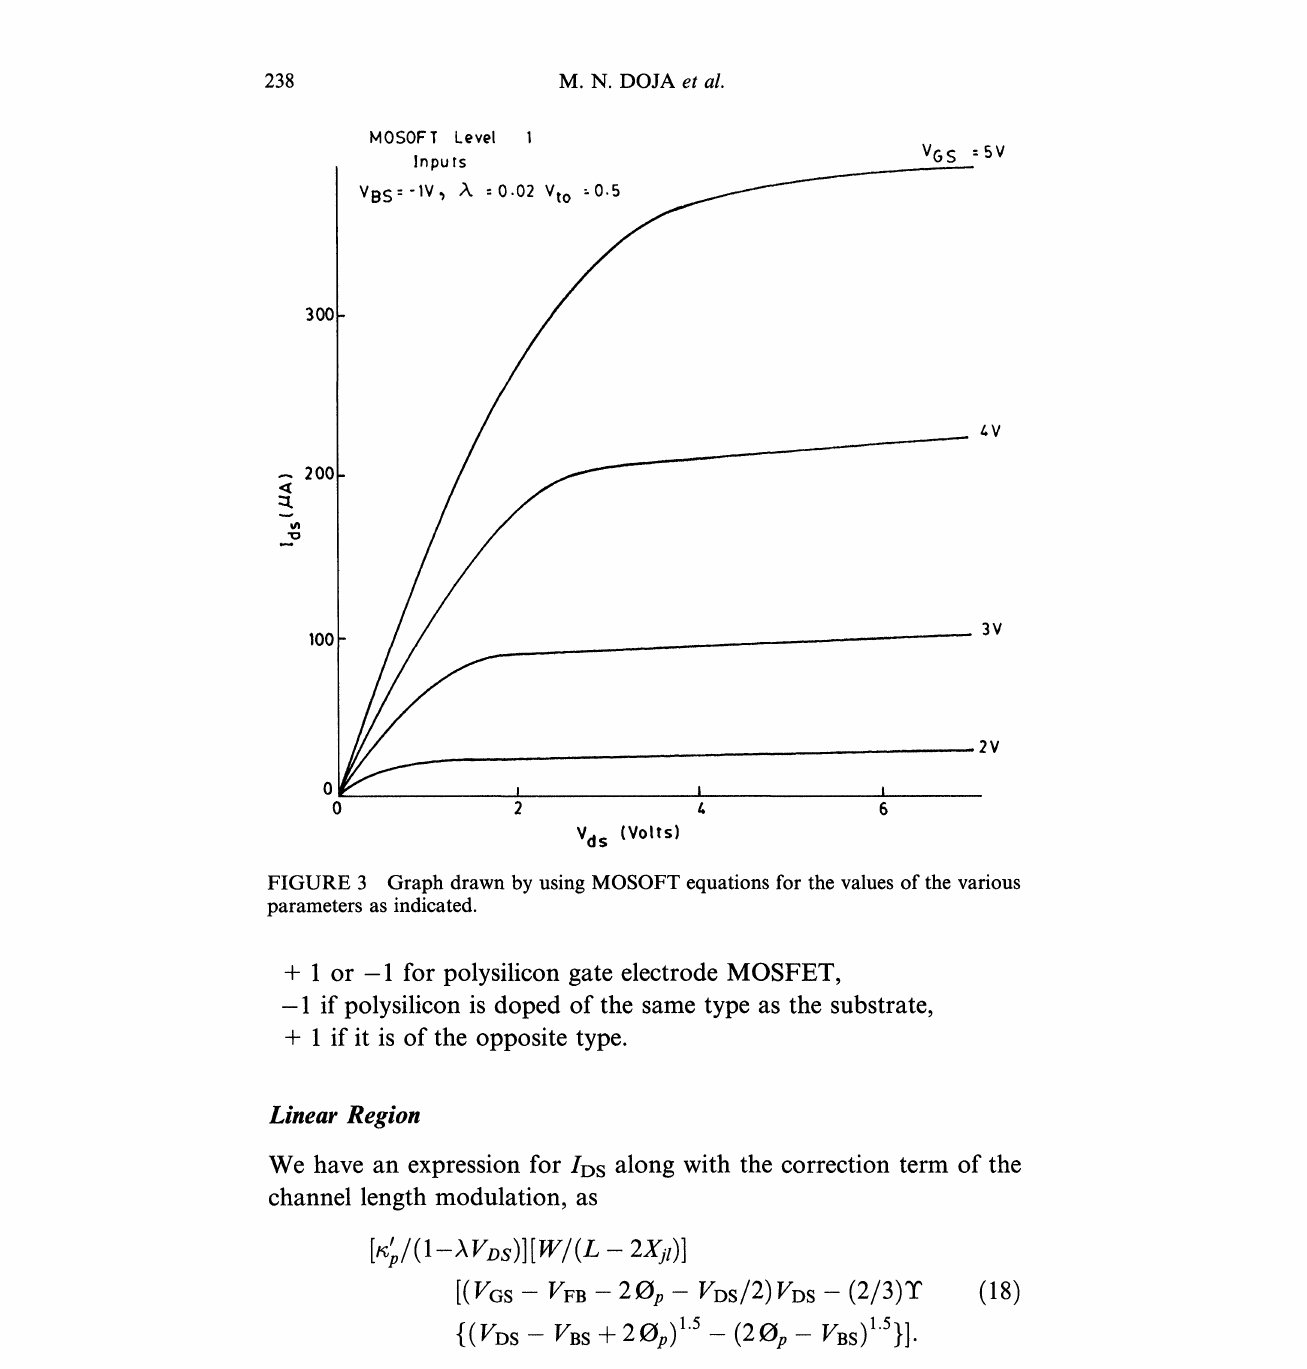
FIGURE 3 Graph drawn by using MOSOFT equations for the values of the various parameters as indicated. + or --1 for polysilicon gate electrode MOSFET, -1 if polysilicon is doped of the same type as the substrate, + if it is of the opposite